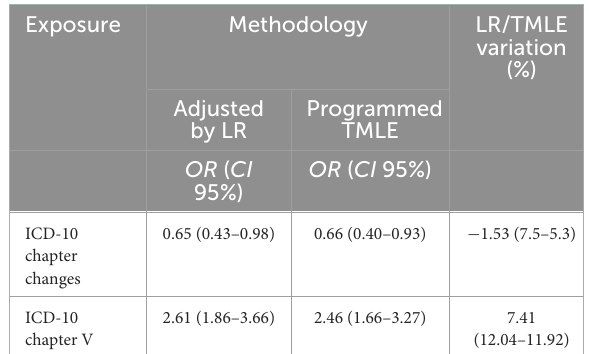
TABLE 4 Comparison of predictive models for the exposures regarding ICD-10 chapter changes and diseases included in ICD-10 chapter V adjusted for the covariates and the return to work with readaptation